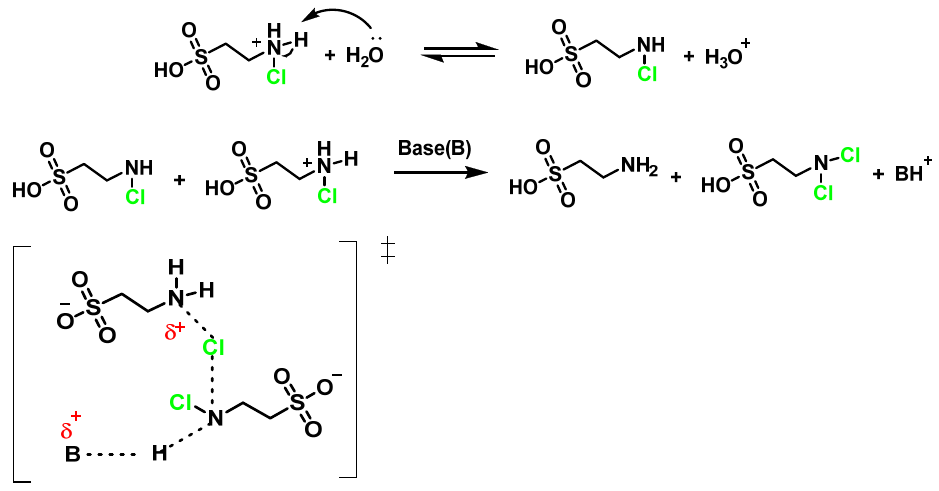
Figure 33. Proposed transition state for the N -chlorotaurin disproportionation reaction.